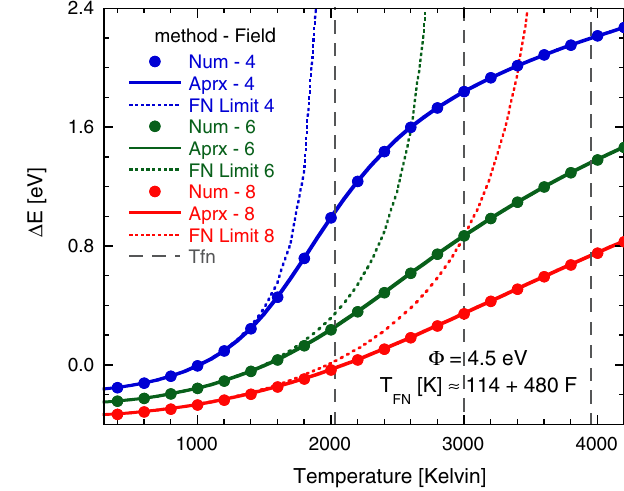
FIG. 14. (Color) The Nottingham term as a function of tempera- ture for copperlike parameters calculated numerically (dots), using Eq. (19) (solid line), or using only the field-dominant terms of N and N 0 containing e (cid:1) s (the basis for the FN equation). The number in the legend corresponds to the apex field in lines (vertical dashes) are where (cid:3) GV = m . T FN